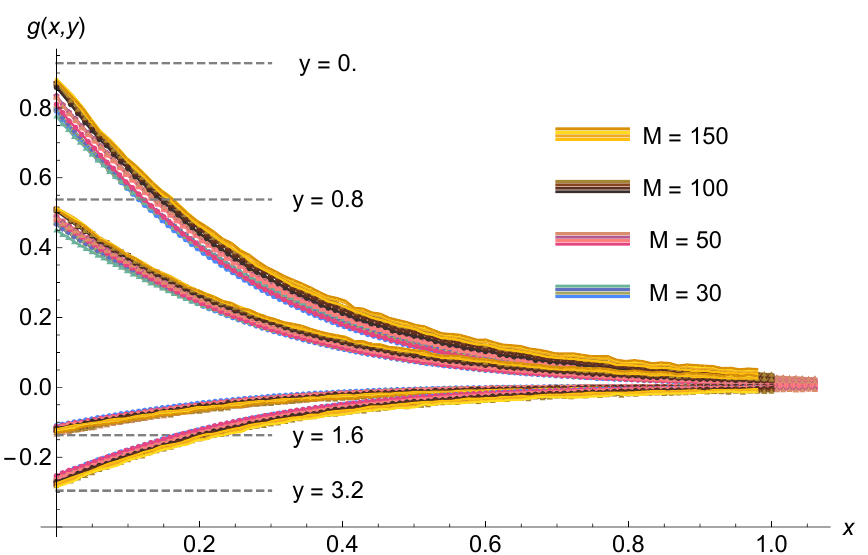
Figure 5: Plot of the numerically calculated scaled smoothed-curvature correlation function g ( x , y ) , obtained by (25) from C ( X , ∆ E ) , as a function of x = ρσ X , for a few fixed values of y = ∆ E /(cid:34) . Horizontal dashed lines show the exact large- M asymptotic (64) of g ( 0, y ) for the corresponding y , and also serve to label the data sets. Curves of different colours correspond to different matrix sizes M , and en- = 0 with fixed correlation length ˜ θ = 1. ergy window widths (cid:34) , all centered at E 0 The gaps at x = 0 between the data curves and the dashed lines decrease for larger M , as seen in figure 3. Collapse of the data curves confirms two-variable scaling and universality. The colours next to each value of M represent, from bot- tom to top, data for (cid:34)/π = 0.33,0.42,0.5,0.67, ( M = 30), 0.25,0.38,0.5,0.63 ( M = 50), 0.3,0.4,0.5,0.6 ( M = 100), and 0.38,0.54,0.69,0.85 ( M = 150) ex- cept that (cid:34)/π = 0.31,0.38,0.46,0.54 for y = 1.6, M = 150, and that for y = 3.2, (cid:34)/π = 0.17,0.25, ( M = 30), 0.13,0.19,0.25,0.31 ( M = 50), 0.15,0.2,0.25,0.3 ( M = 100), and 0.15,0.23,0.31 ( M =